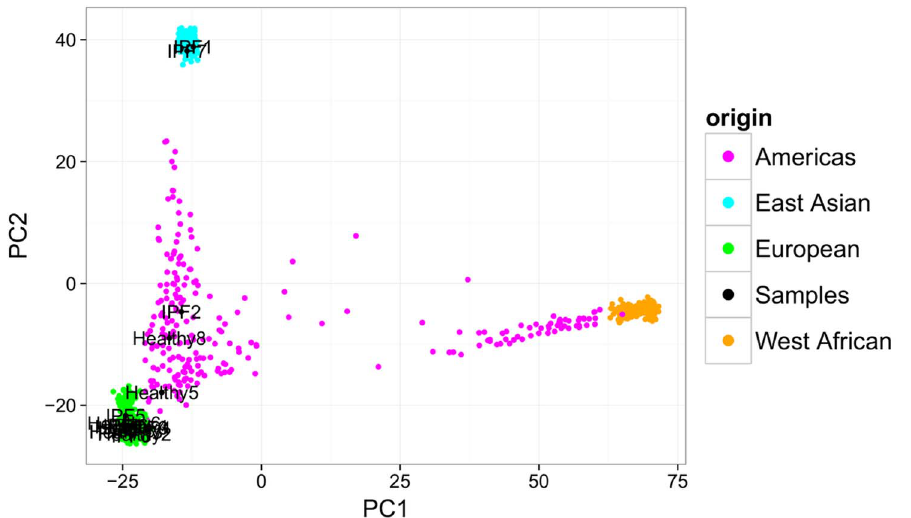
Figure 14. The three genotype clusters correspond to sample population-of-origin. The first two principal components for sample genotypes combined with corresponding Thousand Genomes genotypes are shown.